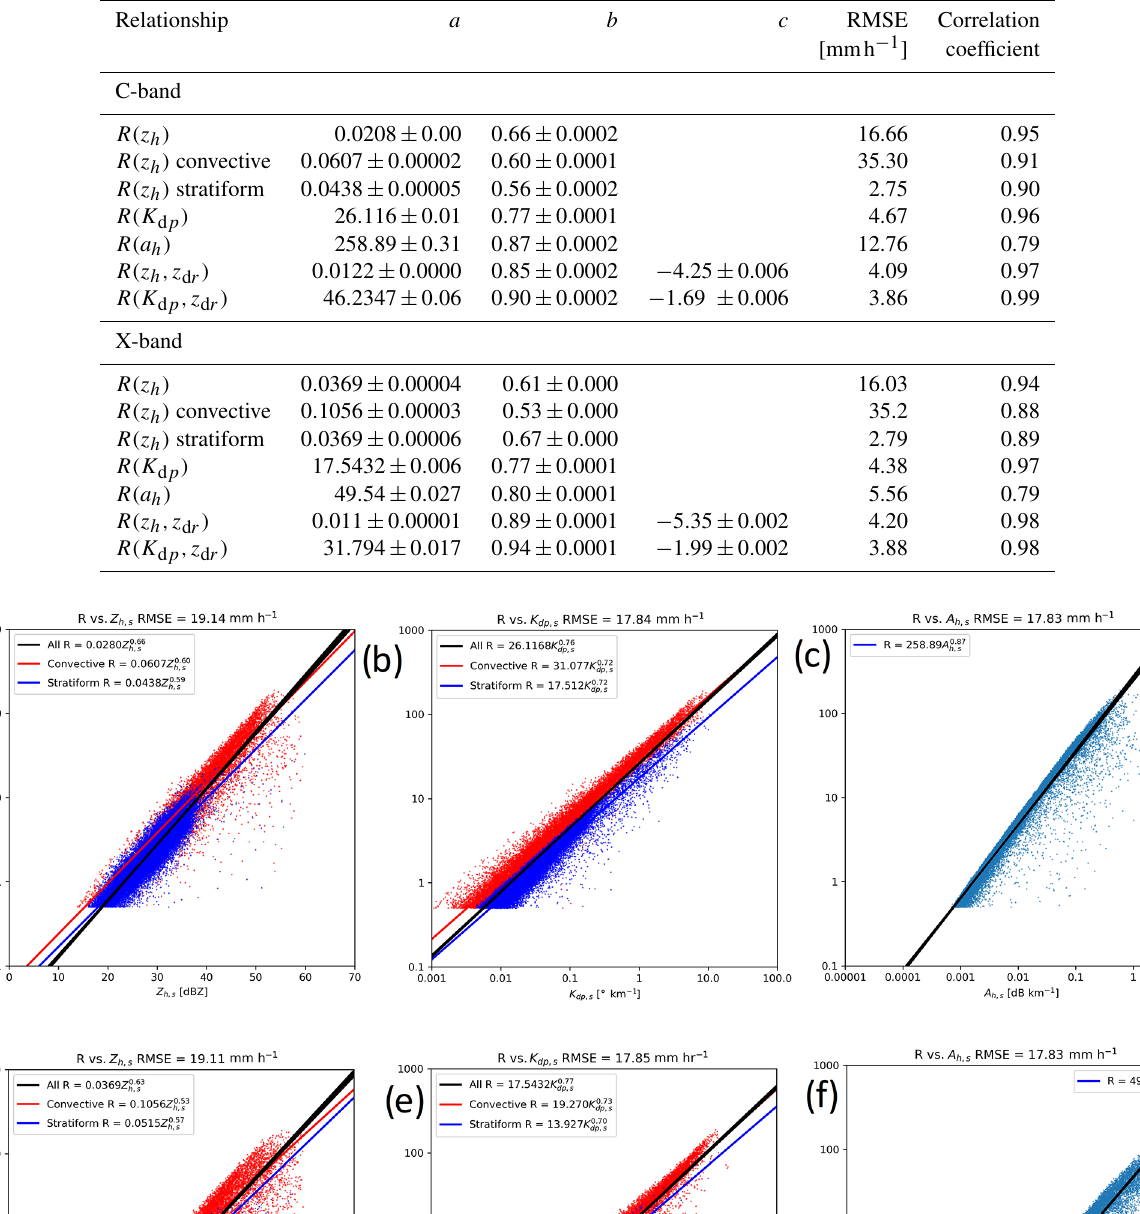
Table 2. The 95% confidence intervals of the generated fit parameters, RMSE, and correlation coefficient for each fit.